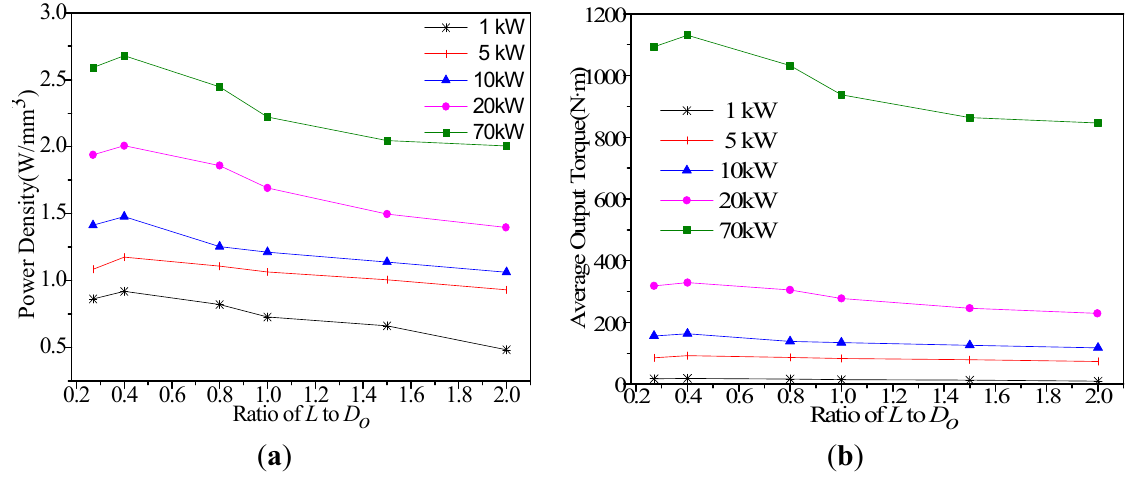
Figure 3. Influences of the ratio k on ( a ) power per unit active volume; and ( b ) average output torque.